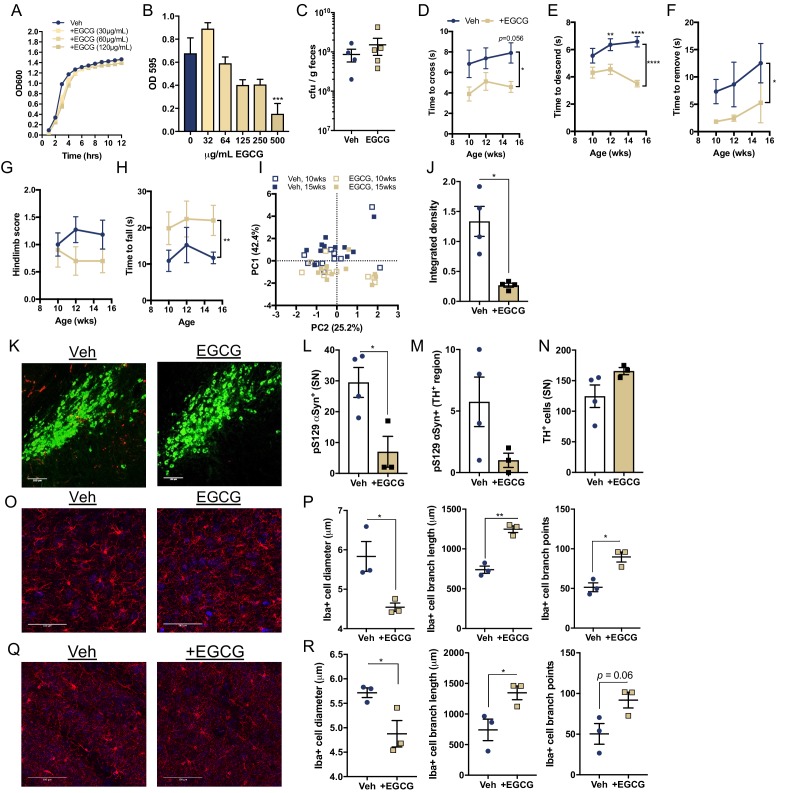
Inhibition of functional amyloid formation dampens progressive pathophysiology.(A) Wild-type E. coli was inoculated into brain-heart infusion broth, containing indicated concentrations of EGCG. Cultures were incubated, with orbital shaking and growth was measured by optical density at 600 nm over time. (B) Crystal violet staining of wild-type E. coli biofilm at 4 days in static culture, with indicated concentrations of epigallocatechin gallate (EGCG); assessed by optical density (OD). (C–R) Germ-free ASO mice were mono-colonized with wild-type E. coli and treated with water alone (Vehicle, Veh) or given EGCG ad lib in drinking water (+EGCG). (C) Fecal pellets were cultured on YESCA agar to determine total viable E. coli. Motor function was assessed at 10, 12, and 15 weeks of age by quantifying (D) beam traversal time, (E) pole descent time, (F) nasal adhesive removal time, (G) hindlimb reflex score, (H) wirehang tests. (I) Principal component analysis of compiled motor scores. (J) Quantification of insoluble αSyn fibrils in the striatum by dot blot assay. (K) Representative images of the substantia nigra in humanized ASO mice stained for TH (green) and pS129 (red) and quantified in (L–N). Representative thin sections of (O) substantia nigra and (Q) striatum were stained for Iba1 (microglia; red) and morphological characteristics of (P) substantia nigra- and (r) striatum-resident microglia quantified. n = 3 (A, O–R) (averaged from 20 to 40 cells for diameters, or 5–7 cells for branching); n = 6–7 (B); n = 4–5 (C, J), n = 10–11 (D–I); n = 3–4 (K–N). Points represent individuals, bars represent the mean and standard error. Time courses analyzed by two-way ANOVA, with Sidak post-hoc test for between group comparisons indicated above individual time points, and brackets indicating significance between treatments. Data in (J) analyzed by two-tailed Mann-Whitney test and (L, P, R) analyzed by two-tailed t-test. *p≤0.05; **p≤0.01; ****p≤0.0001.Figure 4—figure supplement 1—source data 1.Source data and statistical analysis.